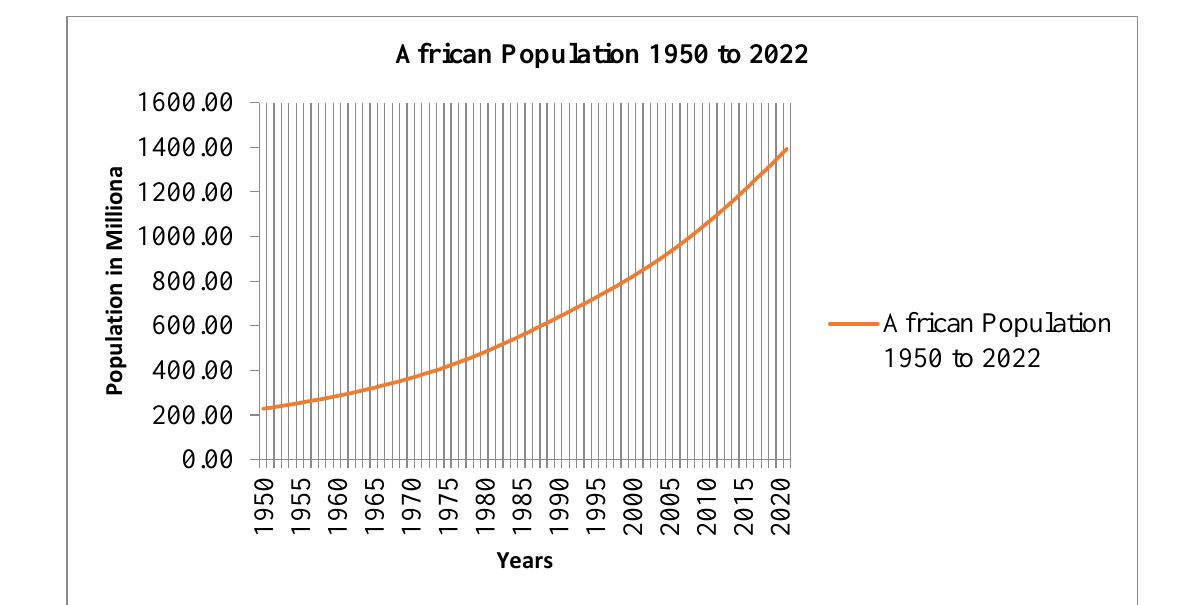
Figure 12. The African population from 1950 to 2021. Source: https://www.macrotrends.net/countries/AFR/africa/population: United Nations world population prospect. Accessed on March 2022.